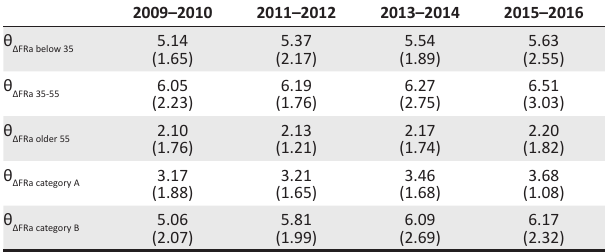
FIGURE 5: Summary of panel data estimations: The functional range of new technology.